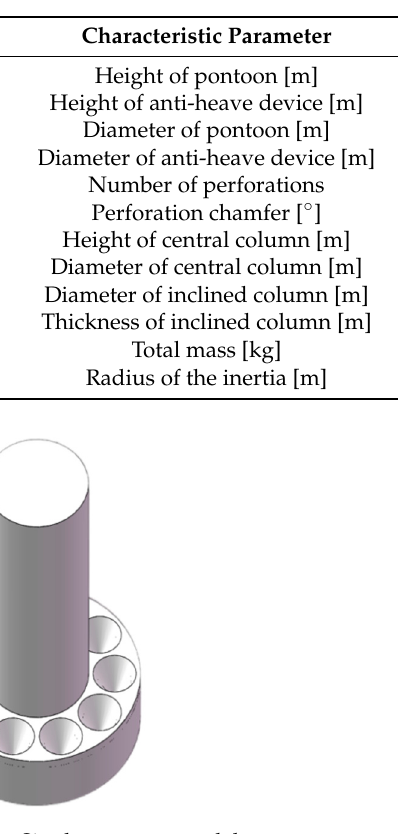
Figure 1. Single pontoon model.